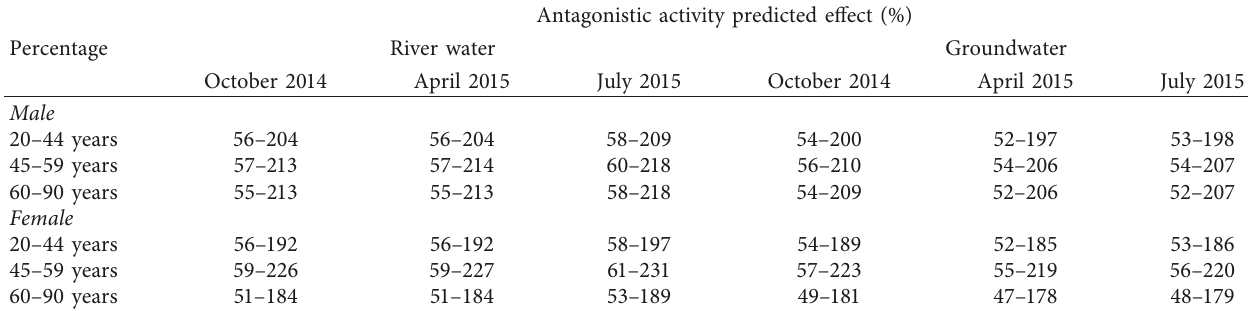
Table 2: Percentage of predicted effects on T3 levels through exposure to the mean level of detected thyroidal antagonist activity in the river water and groundwater samples.